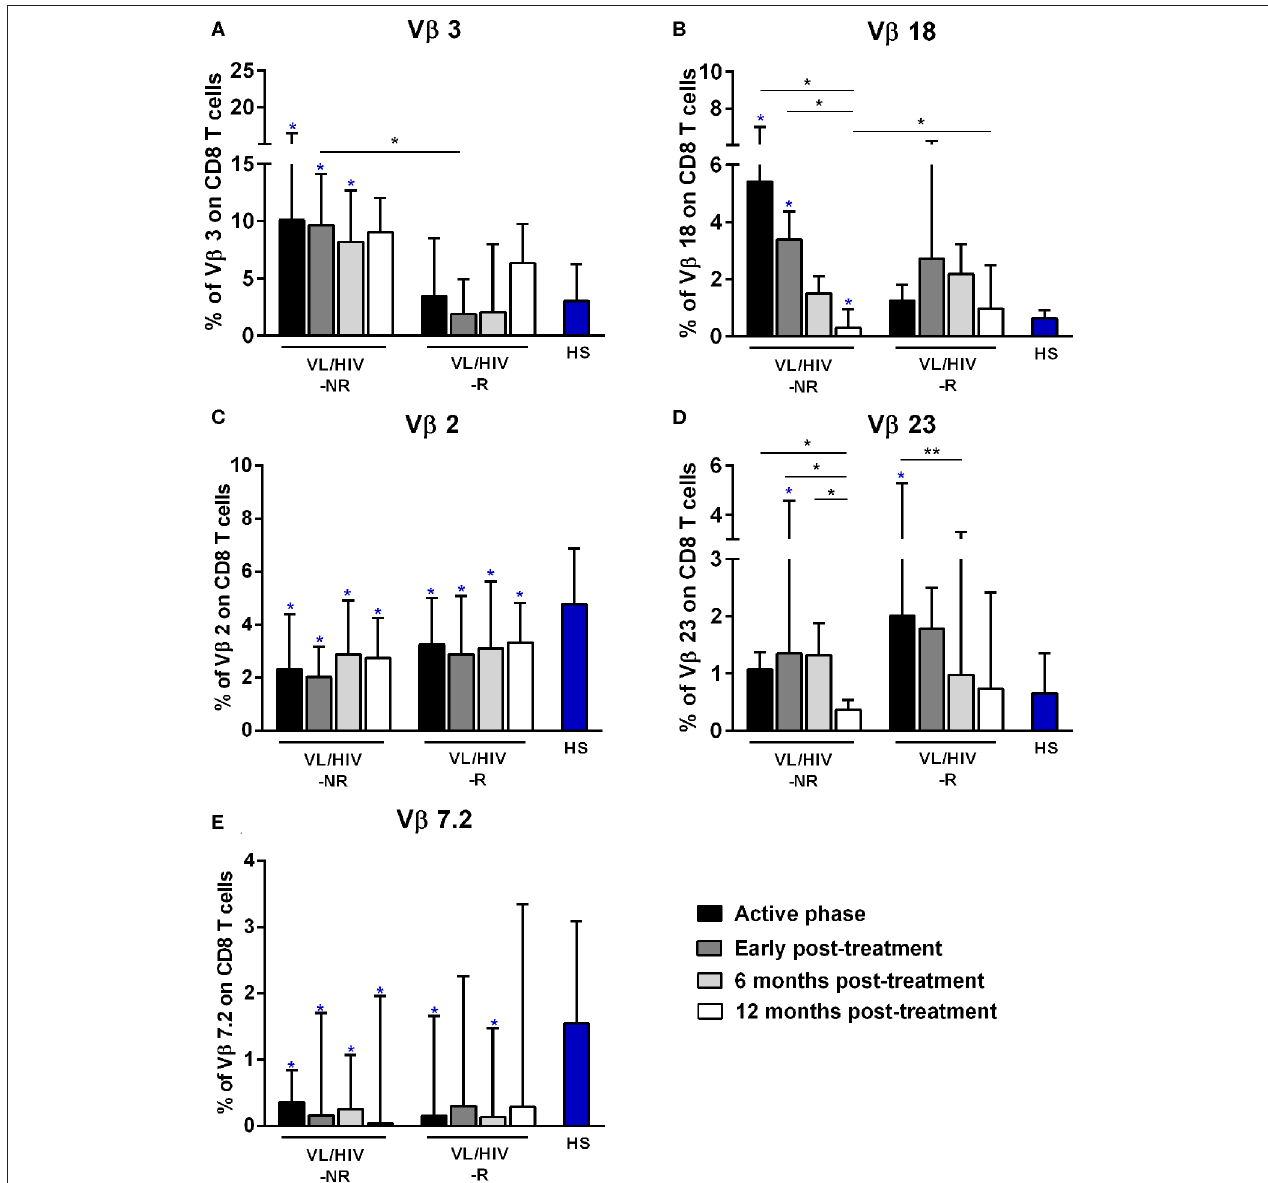
FIGURE 2 | Percentages of the V β families on CD8 + T lymphocytes among non-relapsing (NR) and relapsing (R) visceral leishmaniasis/HIV (VL/HIV) co-infected patients. The mobilization percentages of V β 3 (A) , V β 18 (B) , V β 2 (C) , V β 23 (D), and V β 7.2 (E) in NR-VL/HIV co-infected patients in comparison to R-VL/HIV group. The blue asterisk represents the statistical differences in relation to healthy subjects (HS). The column bar represents the median values with interquartile range. * p < 0.05 ** p <